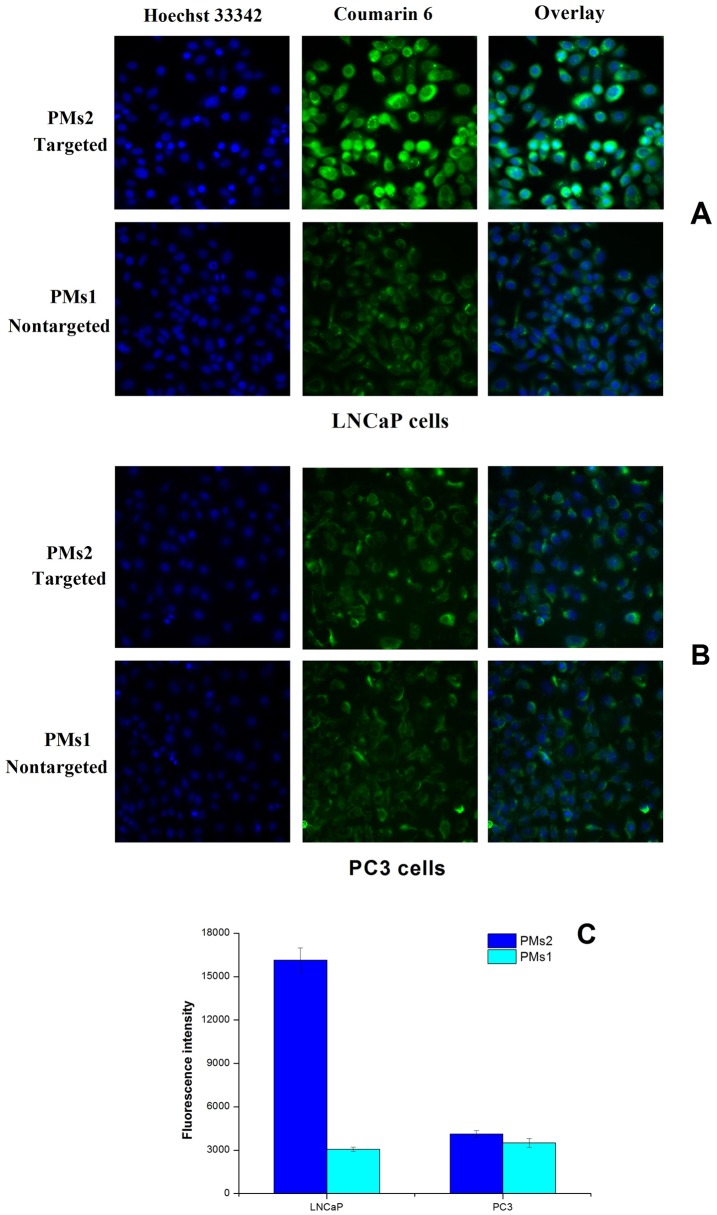
HCSS images of LNCaP (A) and PC3 cells (B) following a 4 h incubation at 37°C with coumarin 6-loaded PMs1 and PMs2, respectively.The cell nuclei were stained with Hoechst 33342 with the blue channel, the coumarin 6-loaded PMs are the green channel. The cellular uptake was visualized by overlaying images displayed by the nuclei channel and the PMs channel. The fluorescence intensity/cell graph of 100 µg/ml coumarin 6-loaded PMs1 and PMs2 with a concentration of 200 µg/ml after 4 h incubation with LNCaP cells and PC3 cells (C).